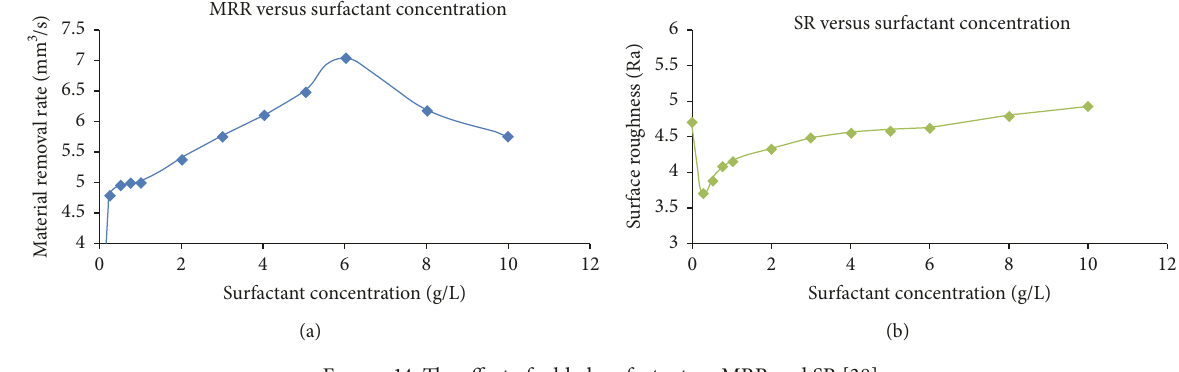
Figure 14: The effect of added surfactant on MRR and SR